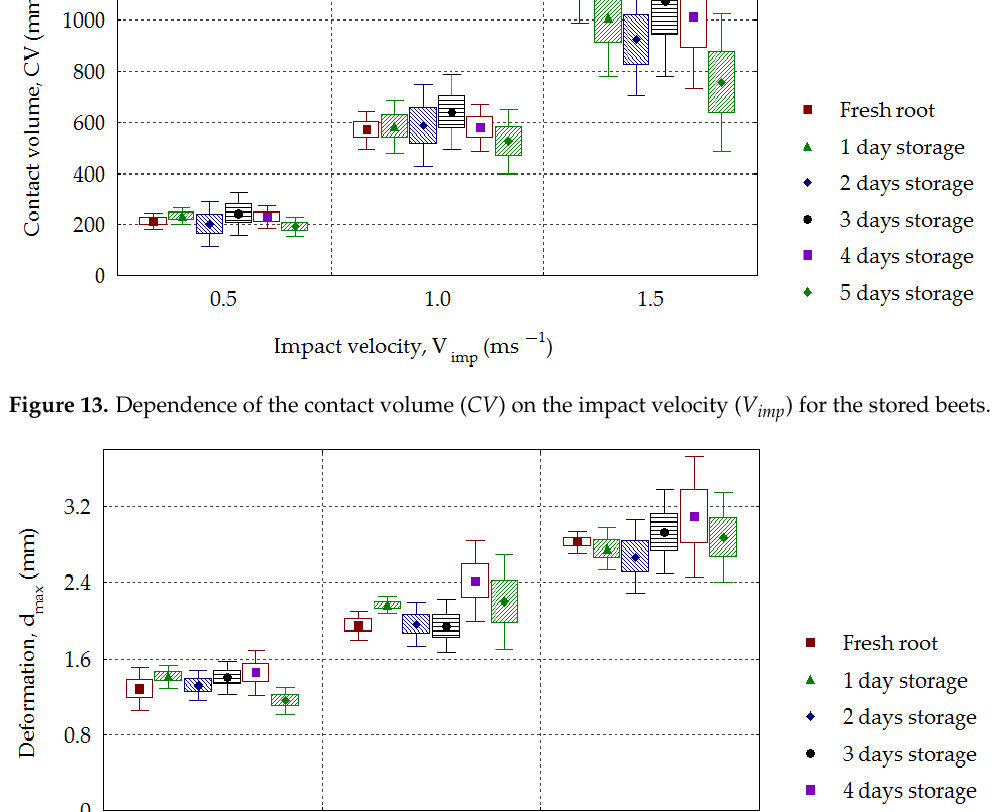
Figure 14. Dependence of the maximal deformation ( d max ) on the impact velocity ( V imp ), taking the storage time ( S t ) into account.